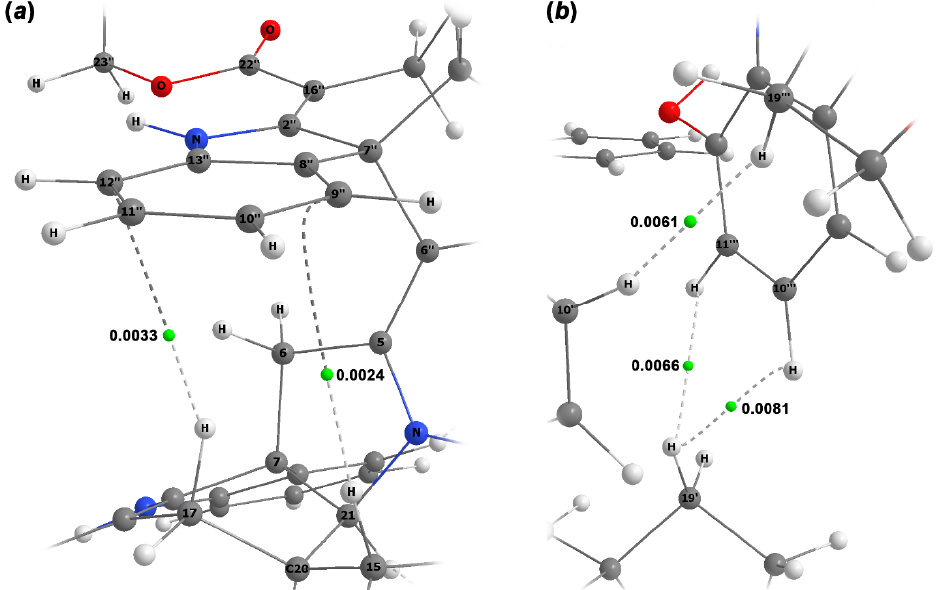
Figure 4. Spatial arrangement of principal non-valent intramolecular interactions of the first and third ( a ), and second and fourth ( b ) subunits of alasmontamine A together with (3,-1) bond critical points (the latter are shown as green circles) with corresponding numerical values of electron density (a.u.).